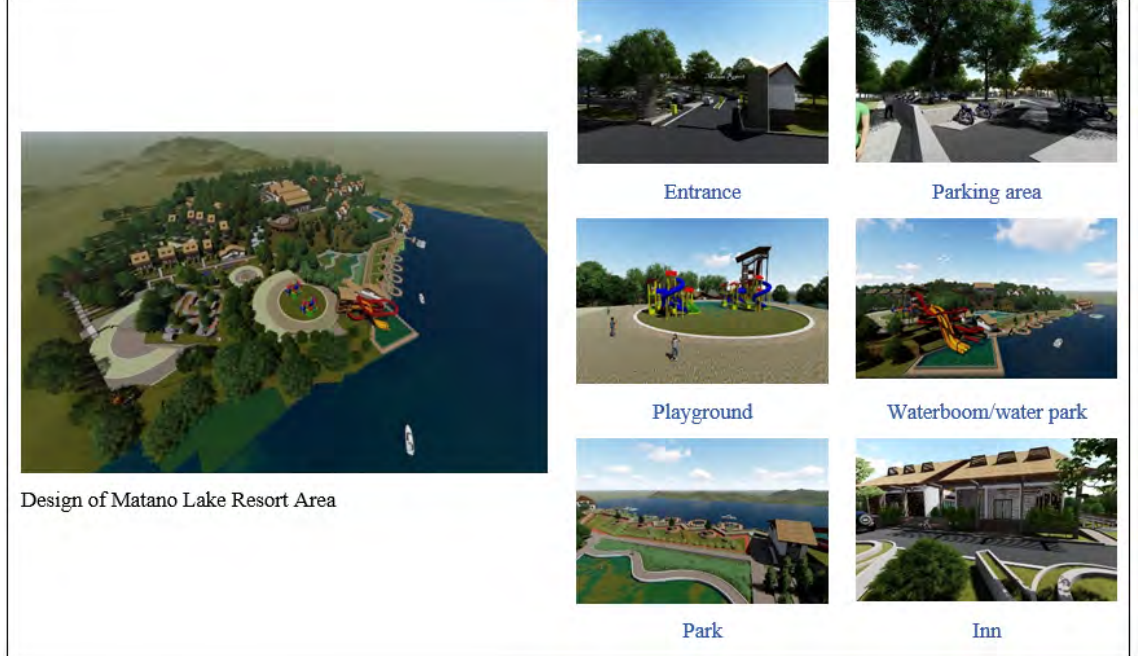
Figure 1. The site plan and the facility of Matano lakeside resort